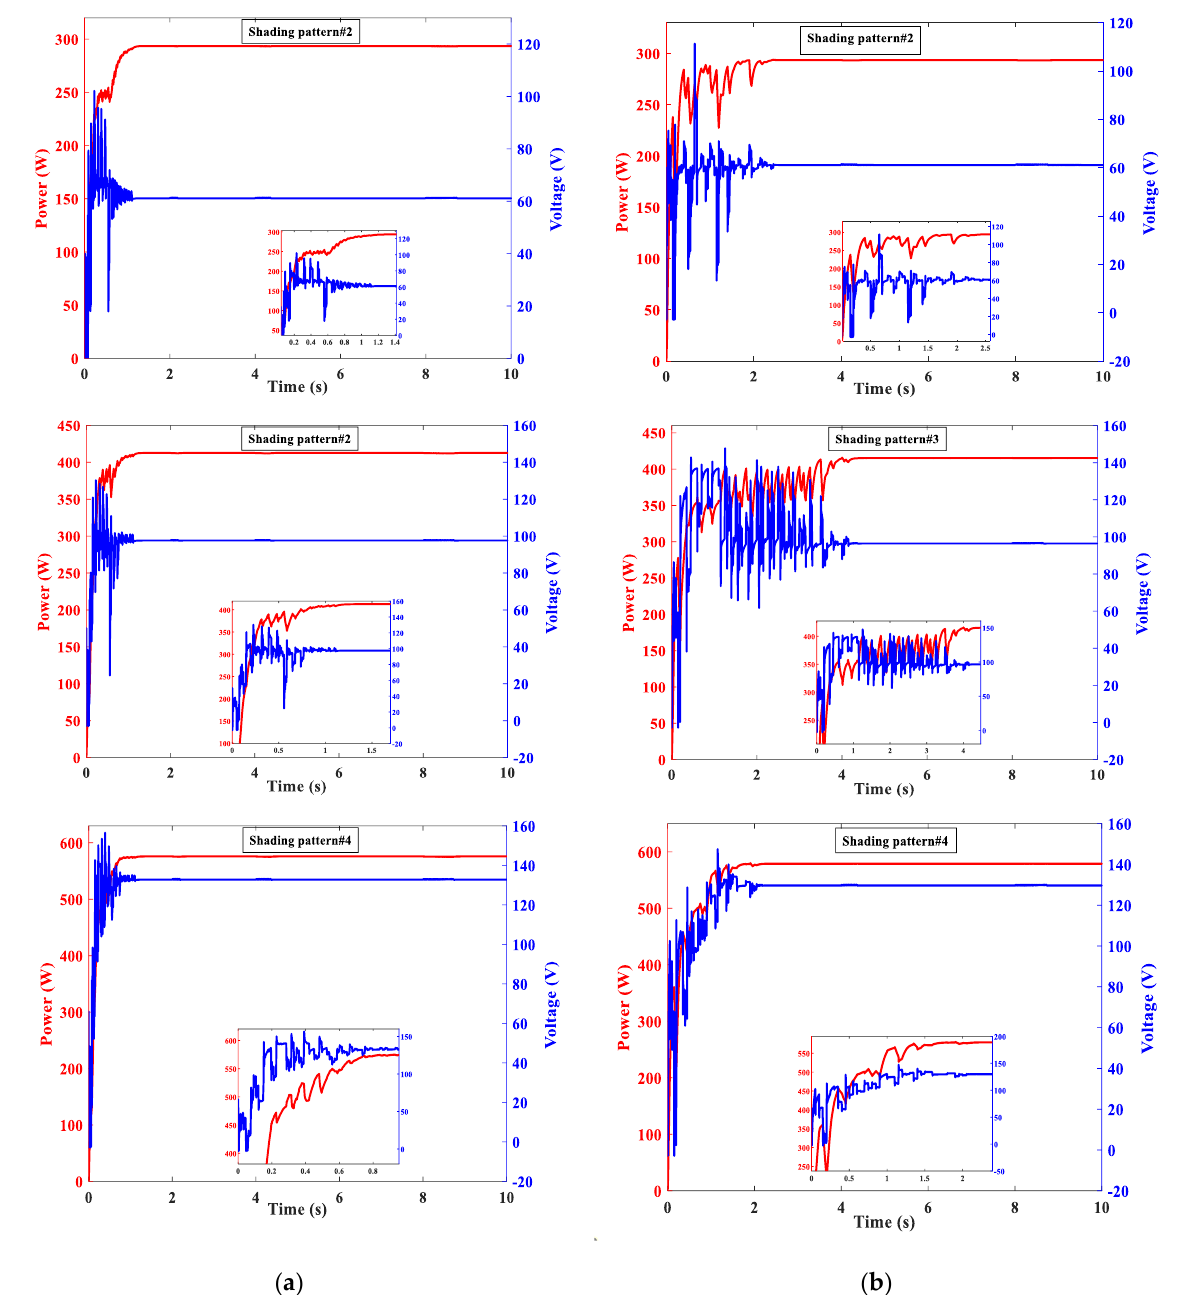
Figure 8. Simulation results of output power and voltage of the SP#2, SP#3, and SP#4 using: ( a ) CSO; ( b ) PSO.